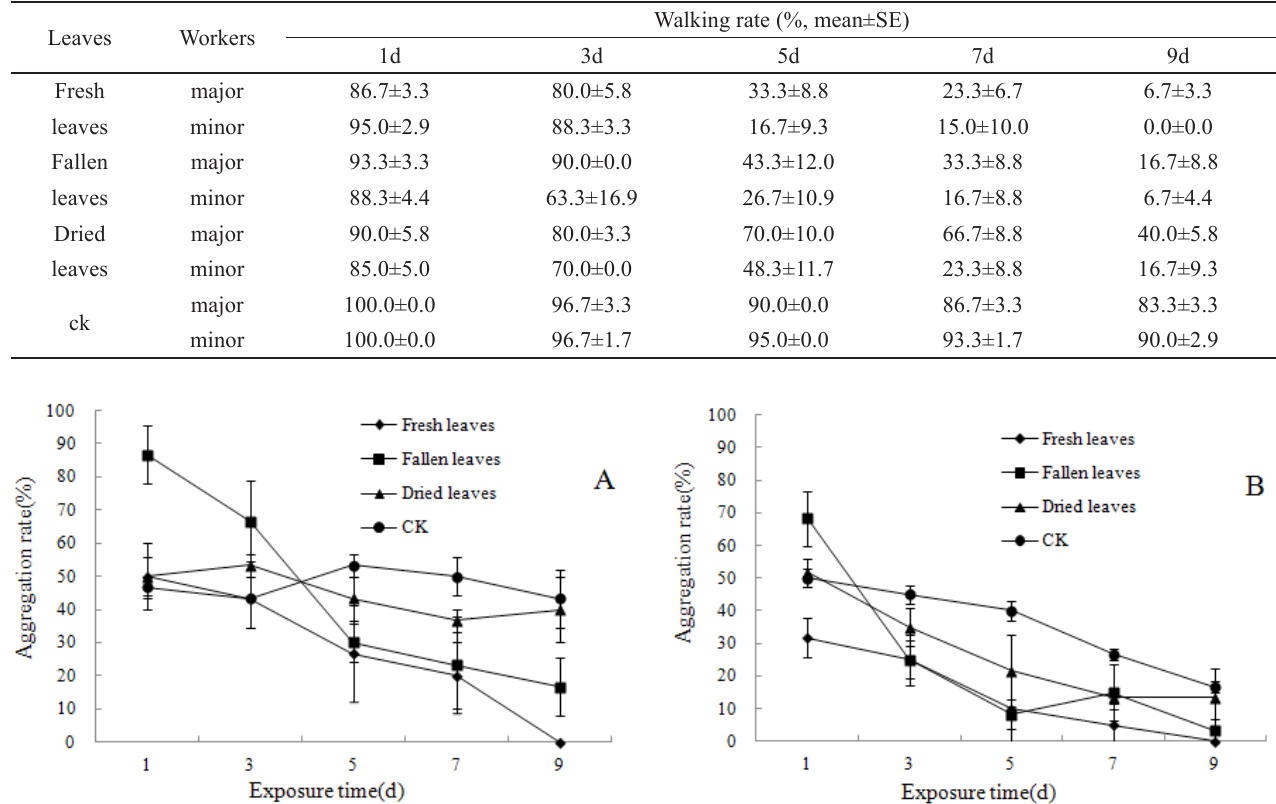
Fig. 4 Effects on aggregation of workers (A: major workers, B: minor workers) after treated with different mashed leaves of M.